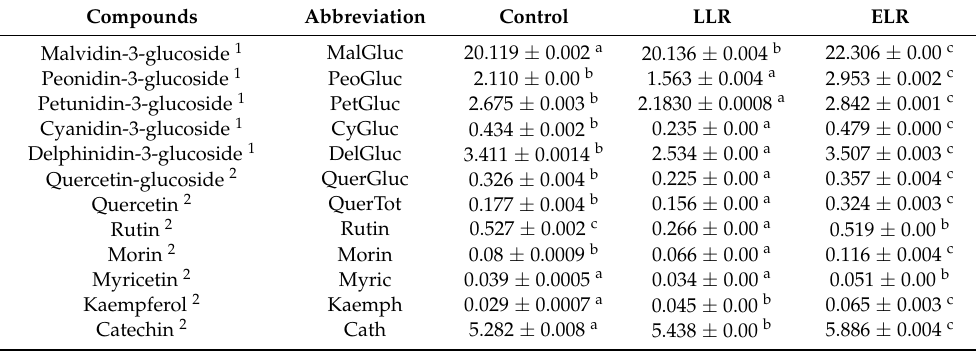
Table 5. Effects of leaf removal timing on the concentrations (mg g − 1 FW) of different phenolic compounds (flavanols and anthocyanins) in the grape berry skin determined by HPLC. LLR, late leaf removal; ELR, early leaf removal. The results from representative year (2012) are shown. Data are means of three replicates ± SD. Different letters in a row denote significant difference between parameter means after Tukey’s test following one-way ANOVA ( p < 0.05).